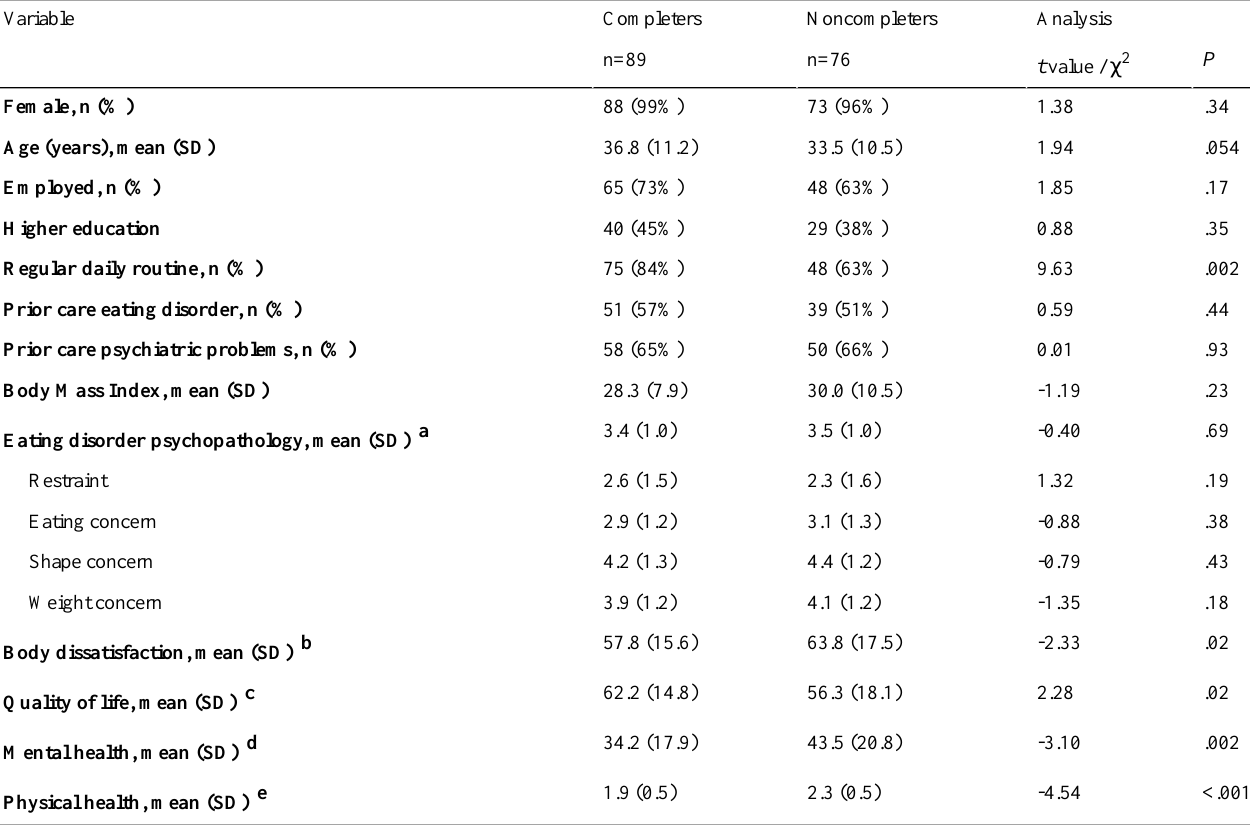
Table 2. Differences in baseline characteristics between completers and